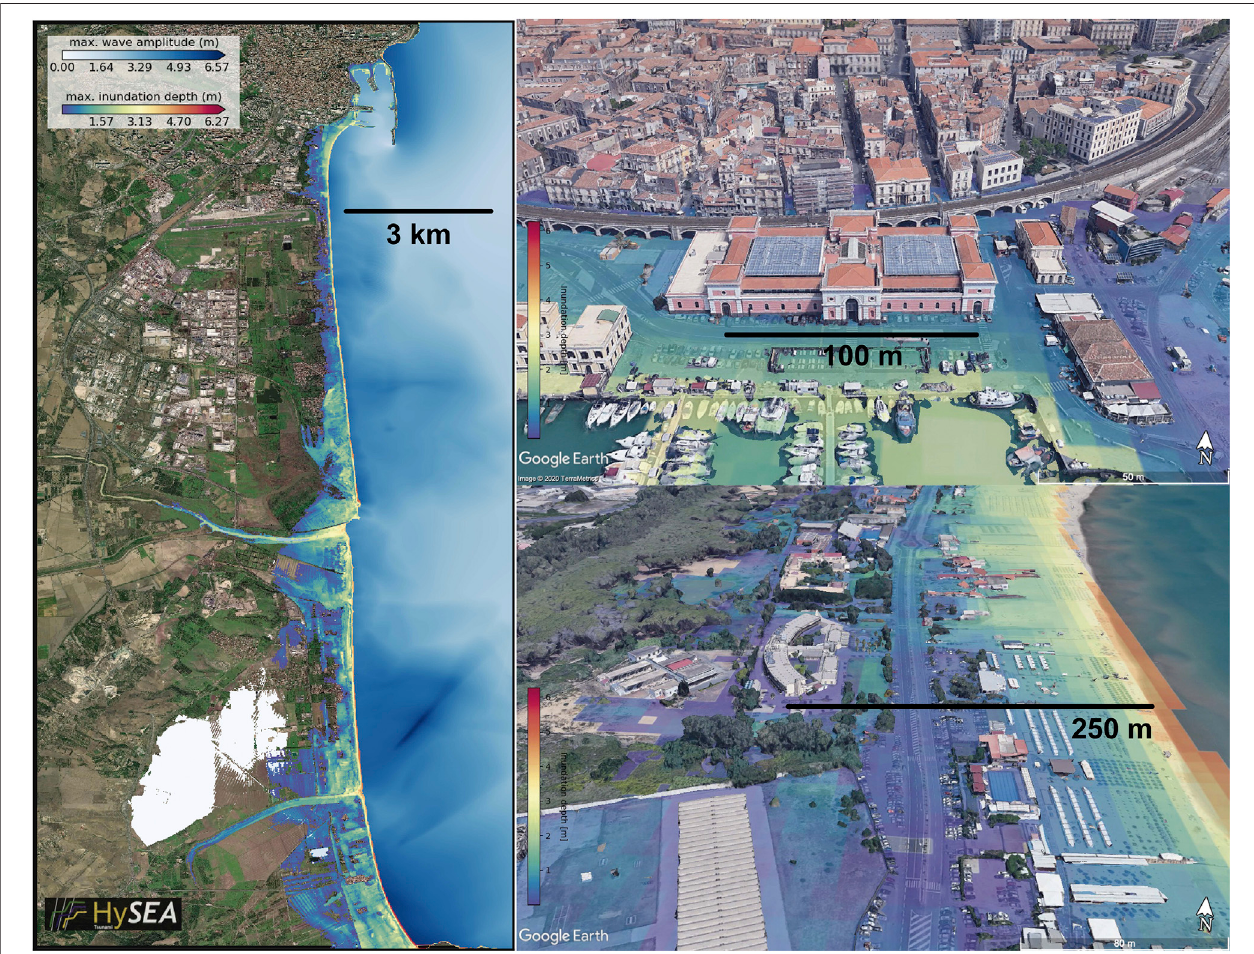
FIGURE 7 | Inundation visualizations at different scales at and close to Catania, Sicily, for a single scenario HySEA simulation to display fl ow depth in relation to infrastructure and communicationroutes. The maximum waveheight and fl owdepth aredisplayed offshore andonshore,respectively.All imagery fromand available via Google